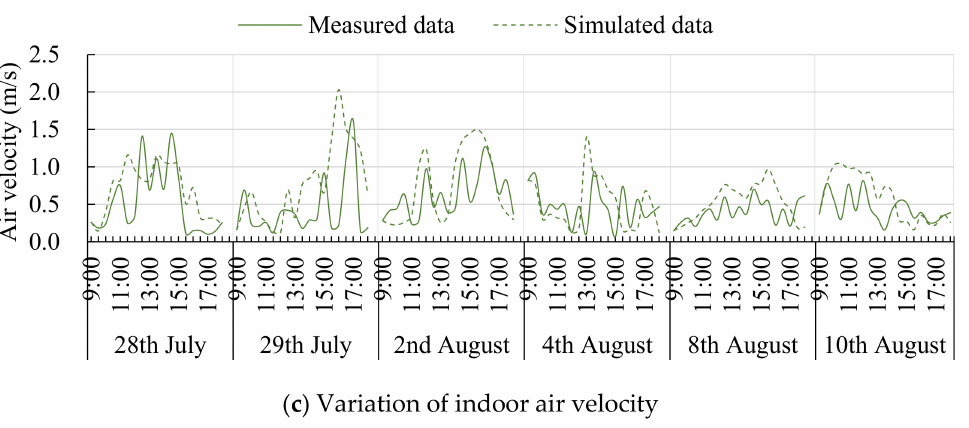
Figure 3. Comparison of the thermal environment variations between measurement and